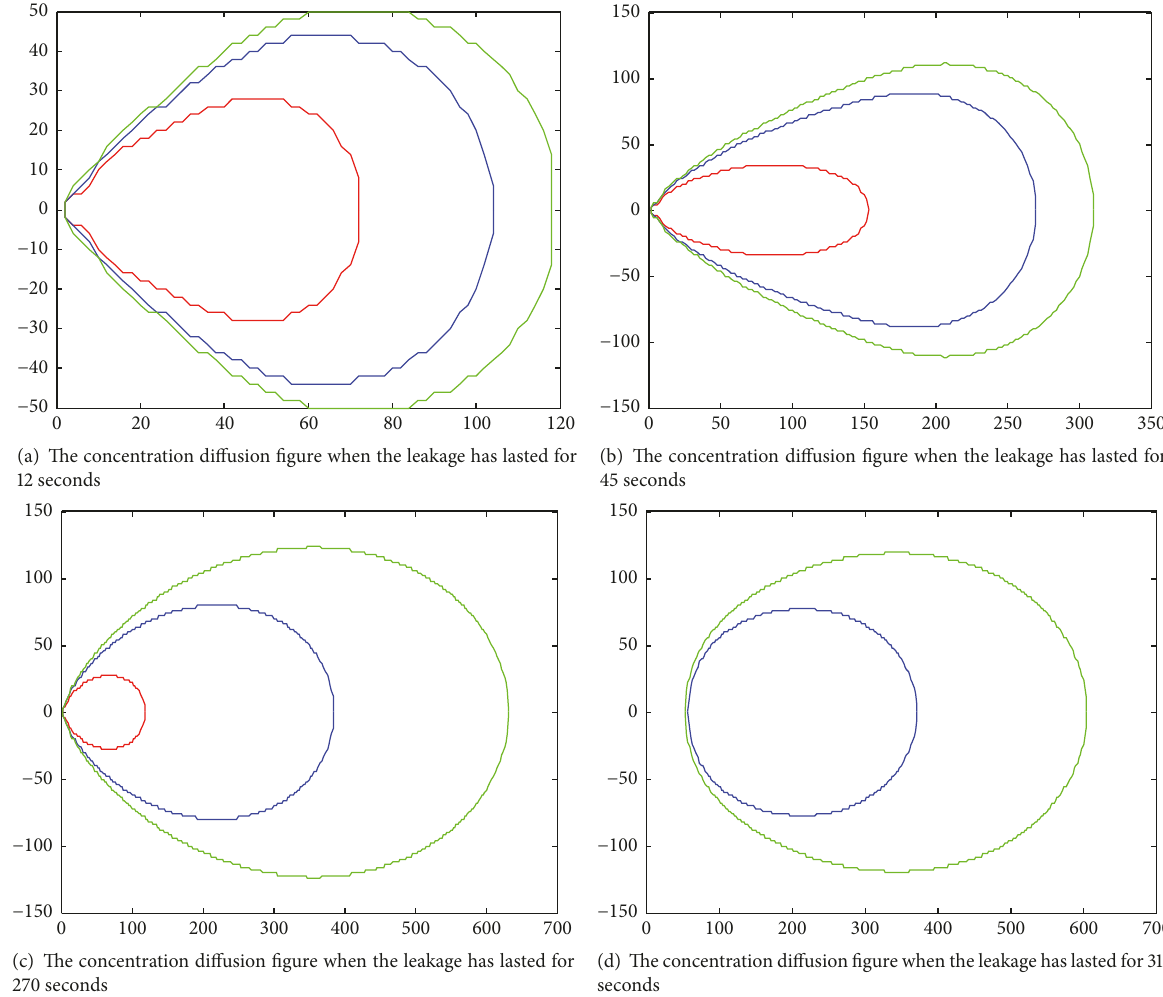
Figure 1: The concentration diffusion with different leakage time.